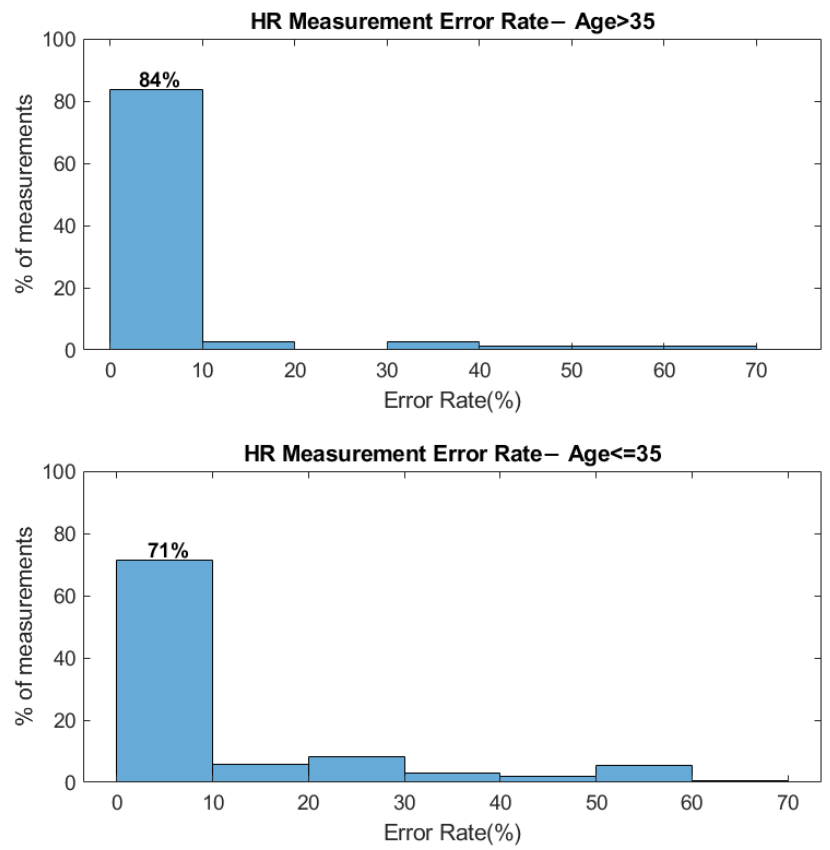
Figure 18. HR measurements error rate within groups of: age > 35 ( top ) and age <= 35 ( bottom